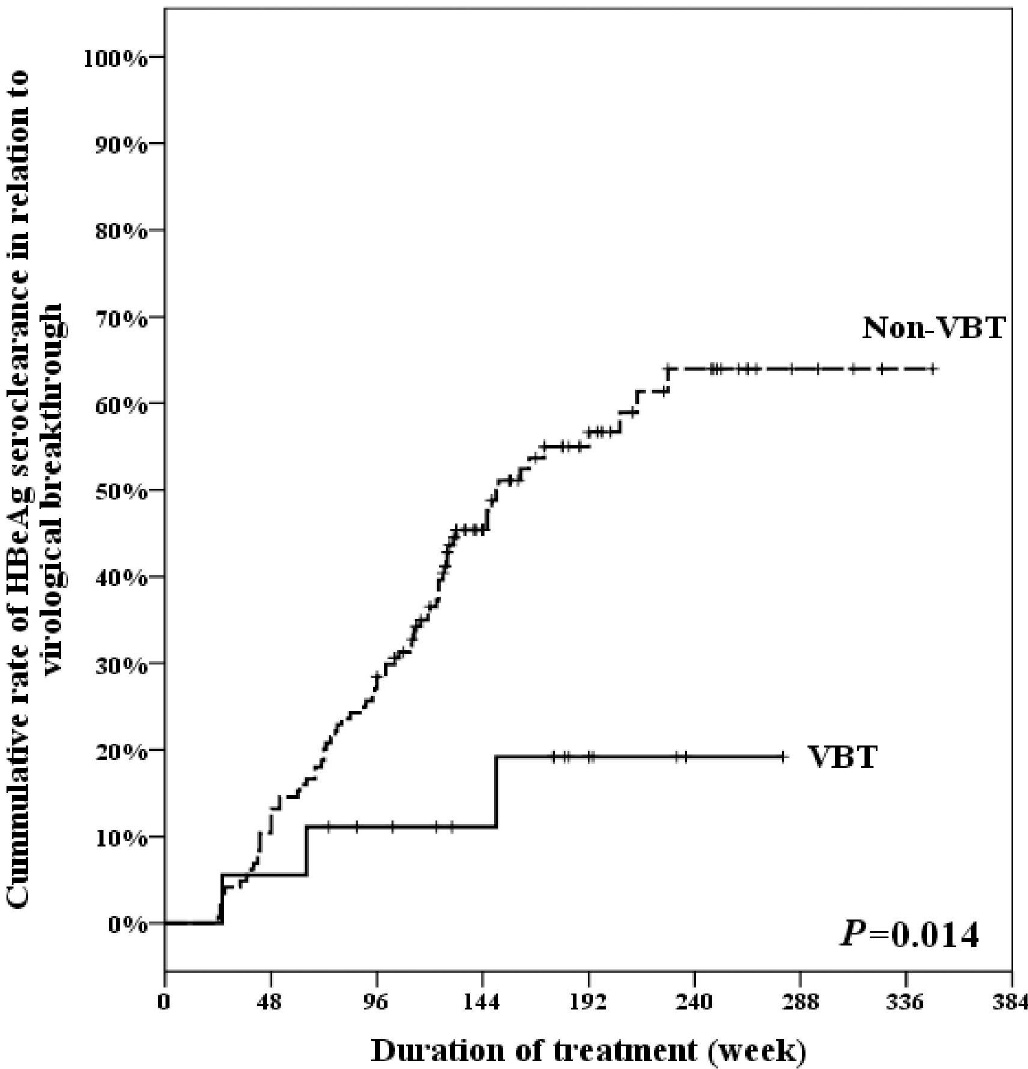
Fig 3. Cumulative rate of HBeAg seroclearance in relation to virological breakthrough. VBT: virological